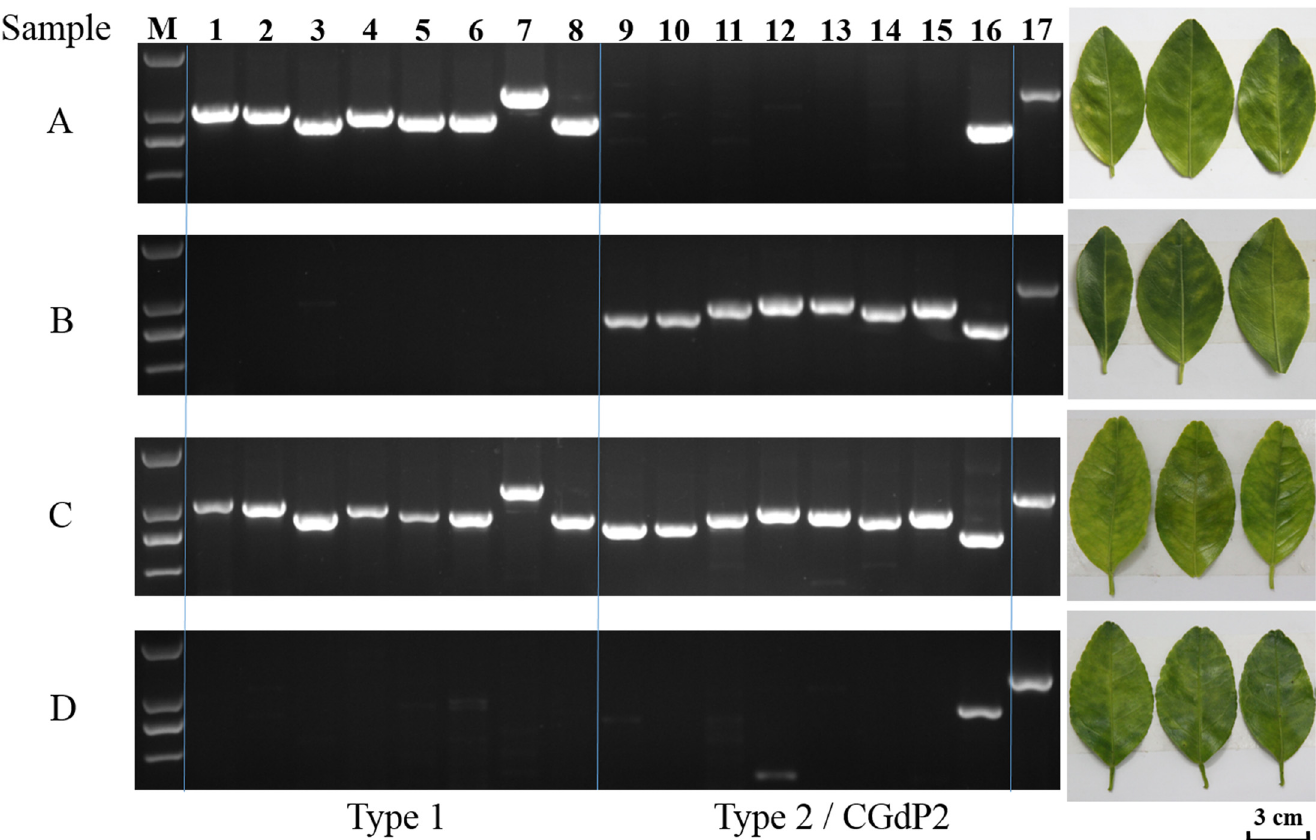
Fig 3. Representative PCR results using prophage type-specific primer sets on samples of “ Candidatus Liberibacter asiaticus ” collected from southern China. (A) Type 1 only; (B) Type 2 only; (C) Type 1 + Type 2; and (D) neither Type 1 nor Type 2. M, DNA ladder (top to bottom in bp: 2,000 bp, 1,000 bp, 750 bp, and 500 bp). Lane 1 – 8, SC1/Type 1 prophage specific primer sets; Lane 9 – 16, SC2 / Type 2 prophage specific primer sets; Lane 17, primer set OI1/OI2c for the 16S rDNA region of “ Ca . L. asiaticus ” . Symptoms of citrus leaves where “ Ca . L. asiaticus ” DNA was extraction are on the right. Sample A and D were collected from HLB-infected citrus trees in Guangdong province. Sample B and C were collected from HLB-infected citrus trees in Yunnan and Hainan province, respectively.